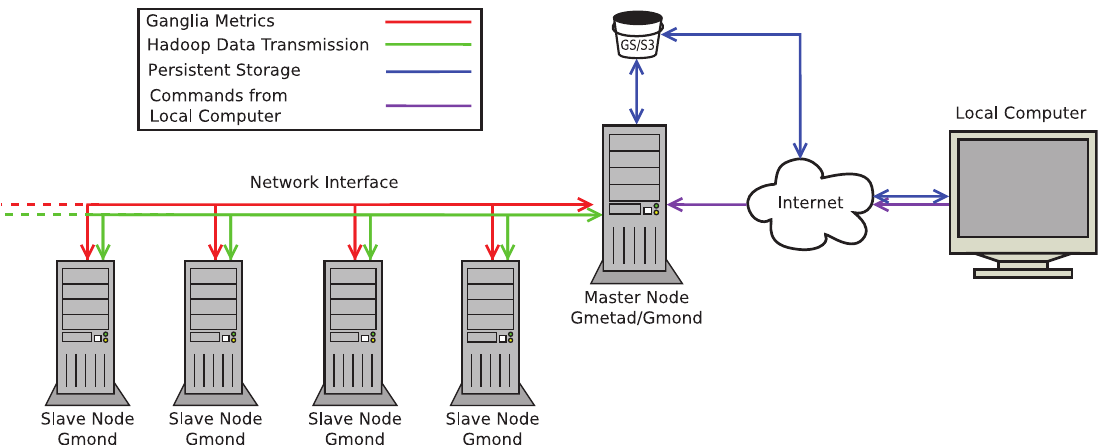
Figure 4. Directions and types of network transfers in our cloud-computing model. There are a variety of different network transfers between the nodes for each of the services in use in our model. Hadoop requires a bidirectional transmission of data between the master node and the slave nodes. This is required to coordinate the parallel processing of the cluster, and to allow for data transfer between nodes. Ganglia uses a unidirectional connection from the slave nodes to the master node to transfer the recorded metrics for storage and visualization. The persistent storage (provided by Amazon S3 (Simple Storage Service) or Google Storage, or an alternative method such as an FTP server) is accessed via the master node. The master node uses it to download input files for Crossbow, such as the manifest file and the reference Jar, and to use for persistent storage of the results of the Crossbow job as the instances destroy their storage on termination. Our local computer can also access the persistent storage via the Internet to allow access to upload the input files, or to download the results. The local computer needs to access the master node to initiate Crossbow. In EMR, this is replaced by a web interface and a JavaScript Object Notation Application Programming Interface (JSON API). In GCE, the user is required to remotely log in via Secure Shell (SSH) to commence the